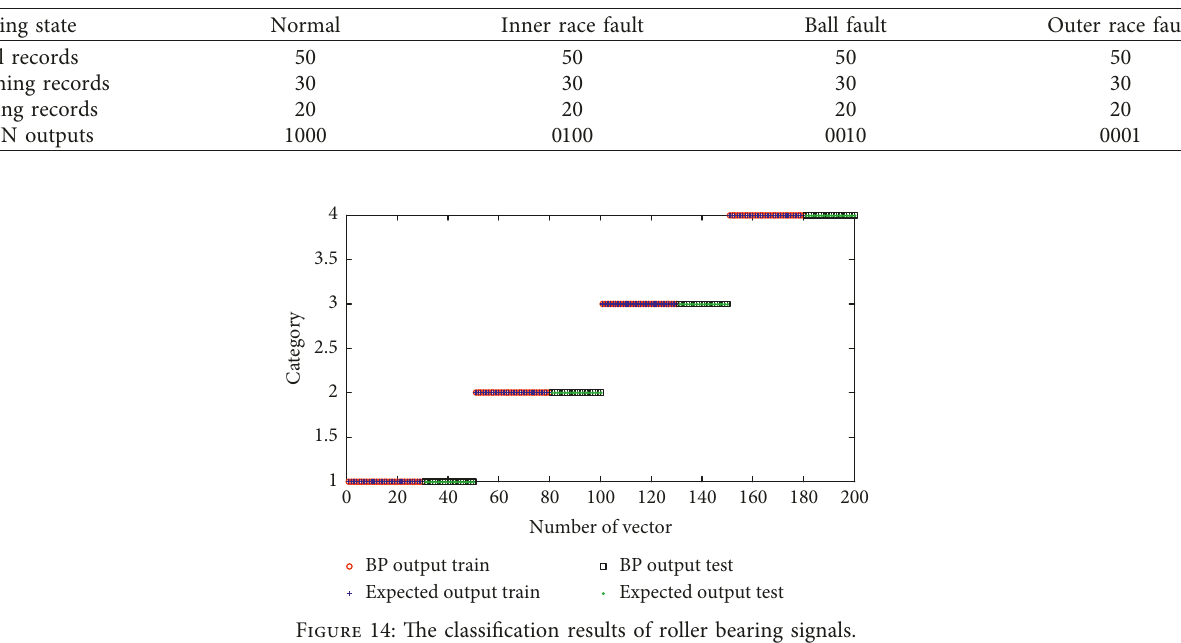
Figure 13: The frequency domain diagram of multiresolution DMD modes of the outer race fault signal, where (a)–(h) are corresponding to signals in Figure 9, respectively. Table 4: Number of records per bearing state and BPNN outputs.